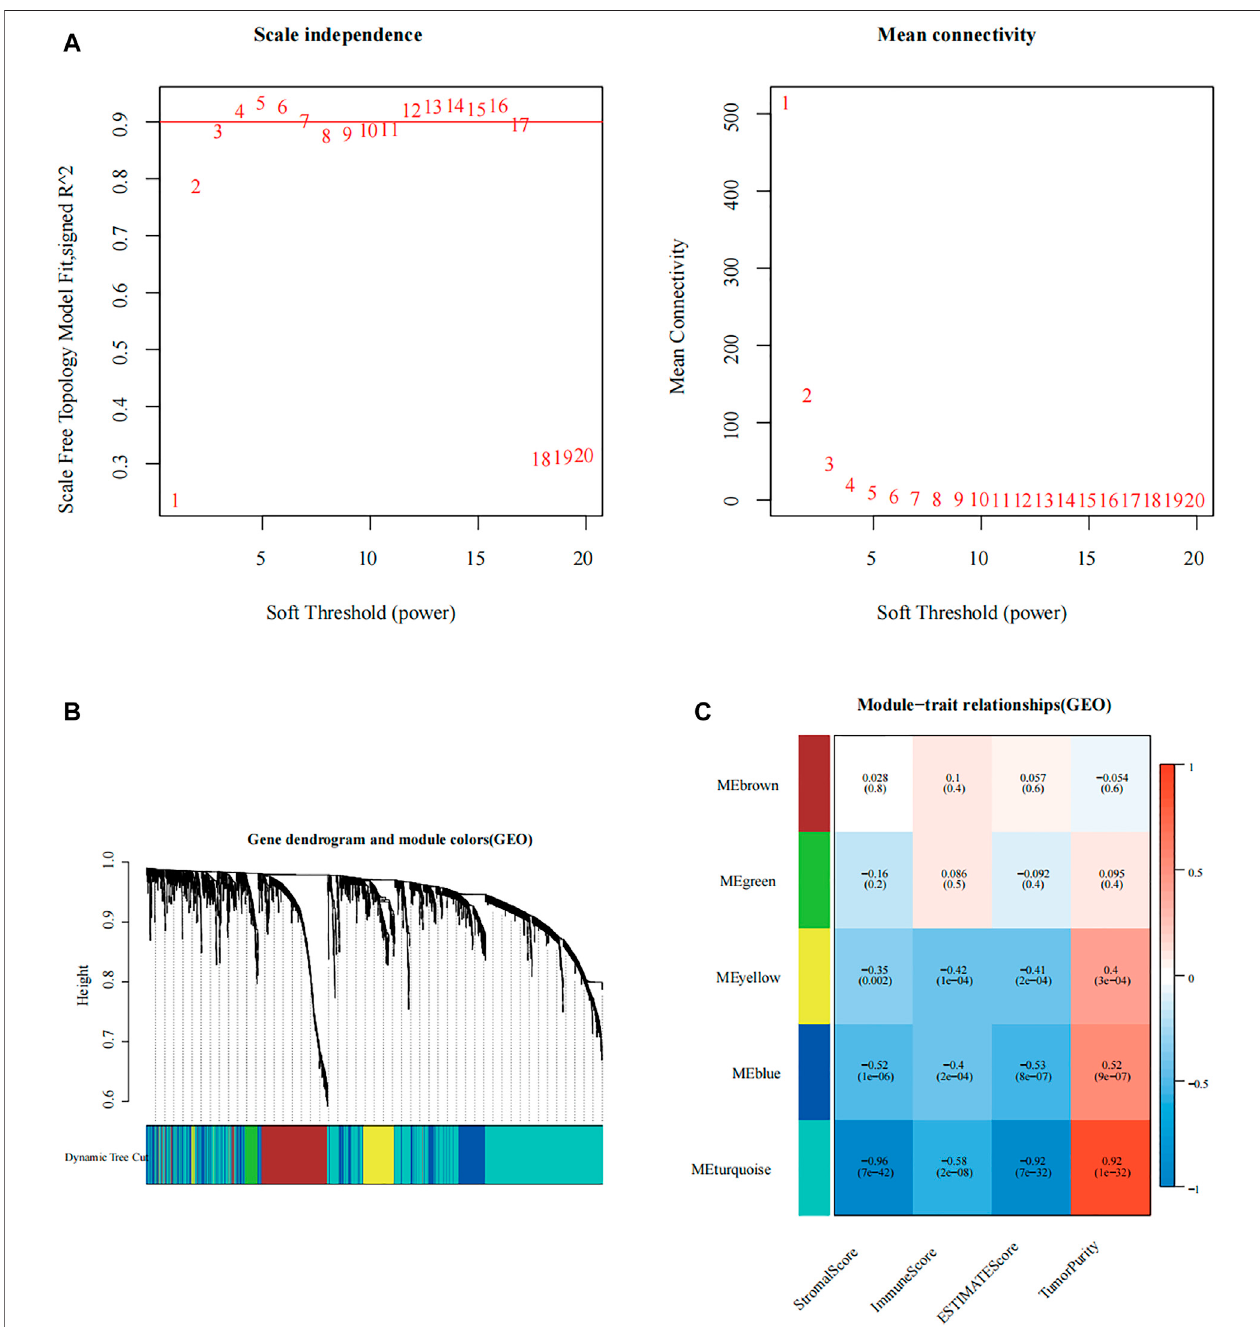
FIGURE 2 | Construction of immune-related modular by weighted gene co-expression network analysis (WGCNA). (A) Analysis of the scale-free fi t index of the 1 – 20 soft threshold power ( β ), and the average connectivity of 1 – 20 soft threshold power. (B) Genes are grouped into various modules by hierarchical clustering, and different colors represent different modules. (C) Relationship between the gene modules and the immune-related information.